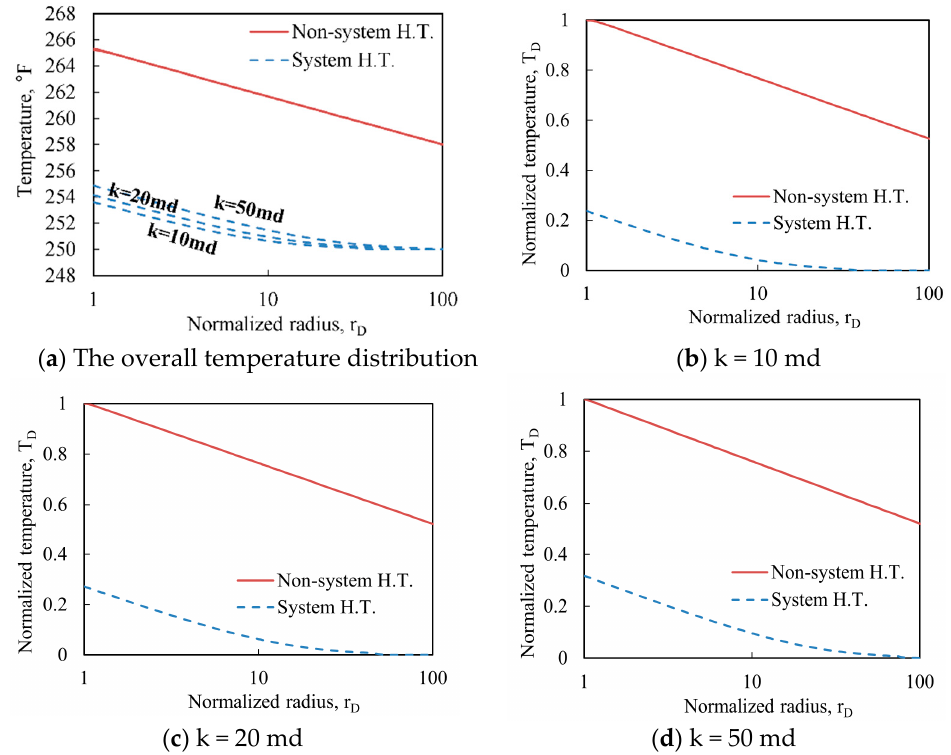
Figure 8. Comparison of radial temperature profiles of the two models at different permeability: ( a ) the overall temperature distribution: ( b ) k = 10 md; ( c ) k = 20 md; ( d ) k = 50 md.